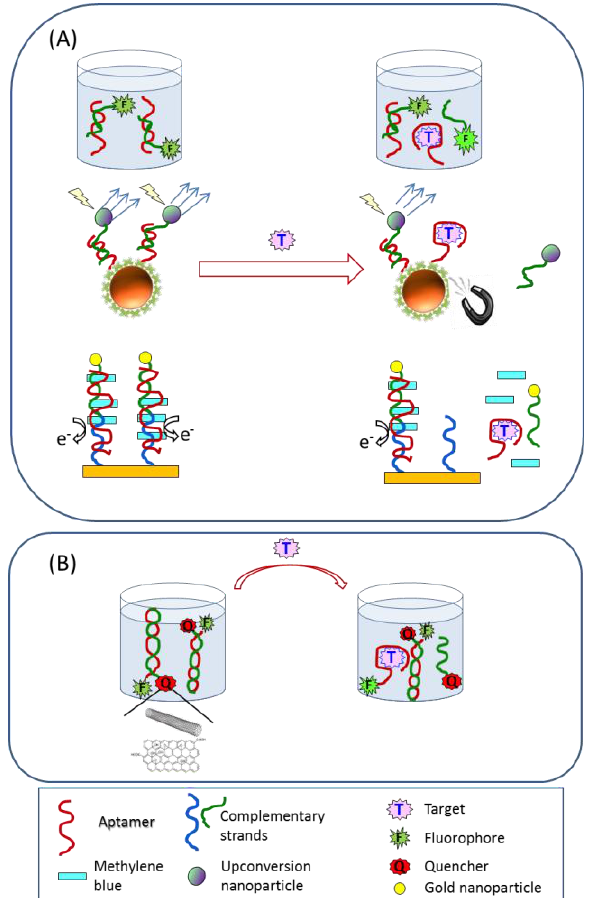
Figure 2. Displacement assay formats for micotoxin analysis in food ( A ) signal-off schemes; ( B ) signal-on